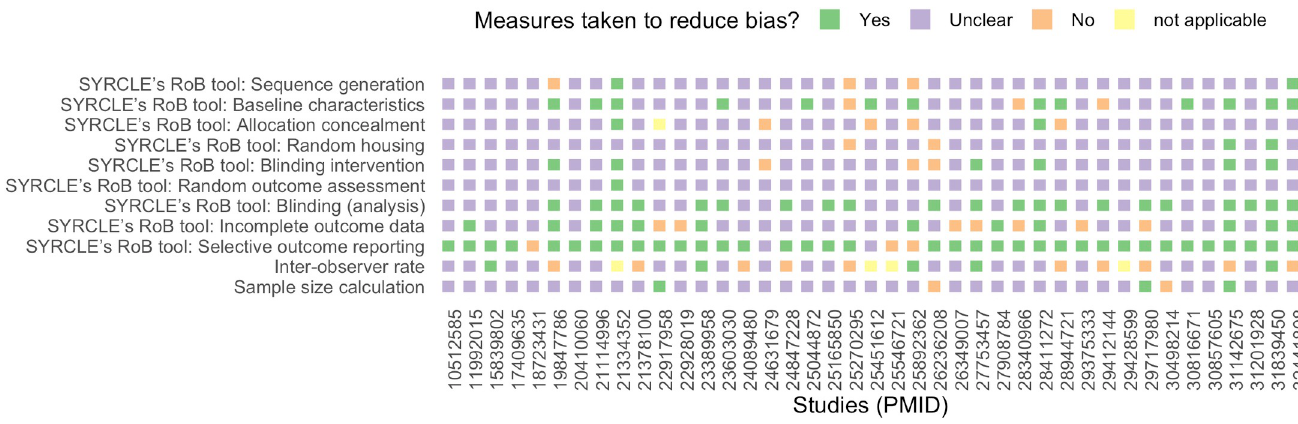
Fig 3. Assessment of study quality (QA) and risk of bias. The risk of bias according to SYRCLE’s risk of bias (RoB) tool [34], for each study, indicated by PubMed ID (PMID), included in the systematic review. The figure also shows if an a priori sample size calculation was performed and -if behavior was scored manually- an inter-observer rate was calculated. Unreported details were scored as an ‘unclear’ risk of bias.